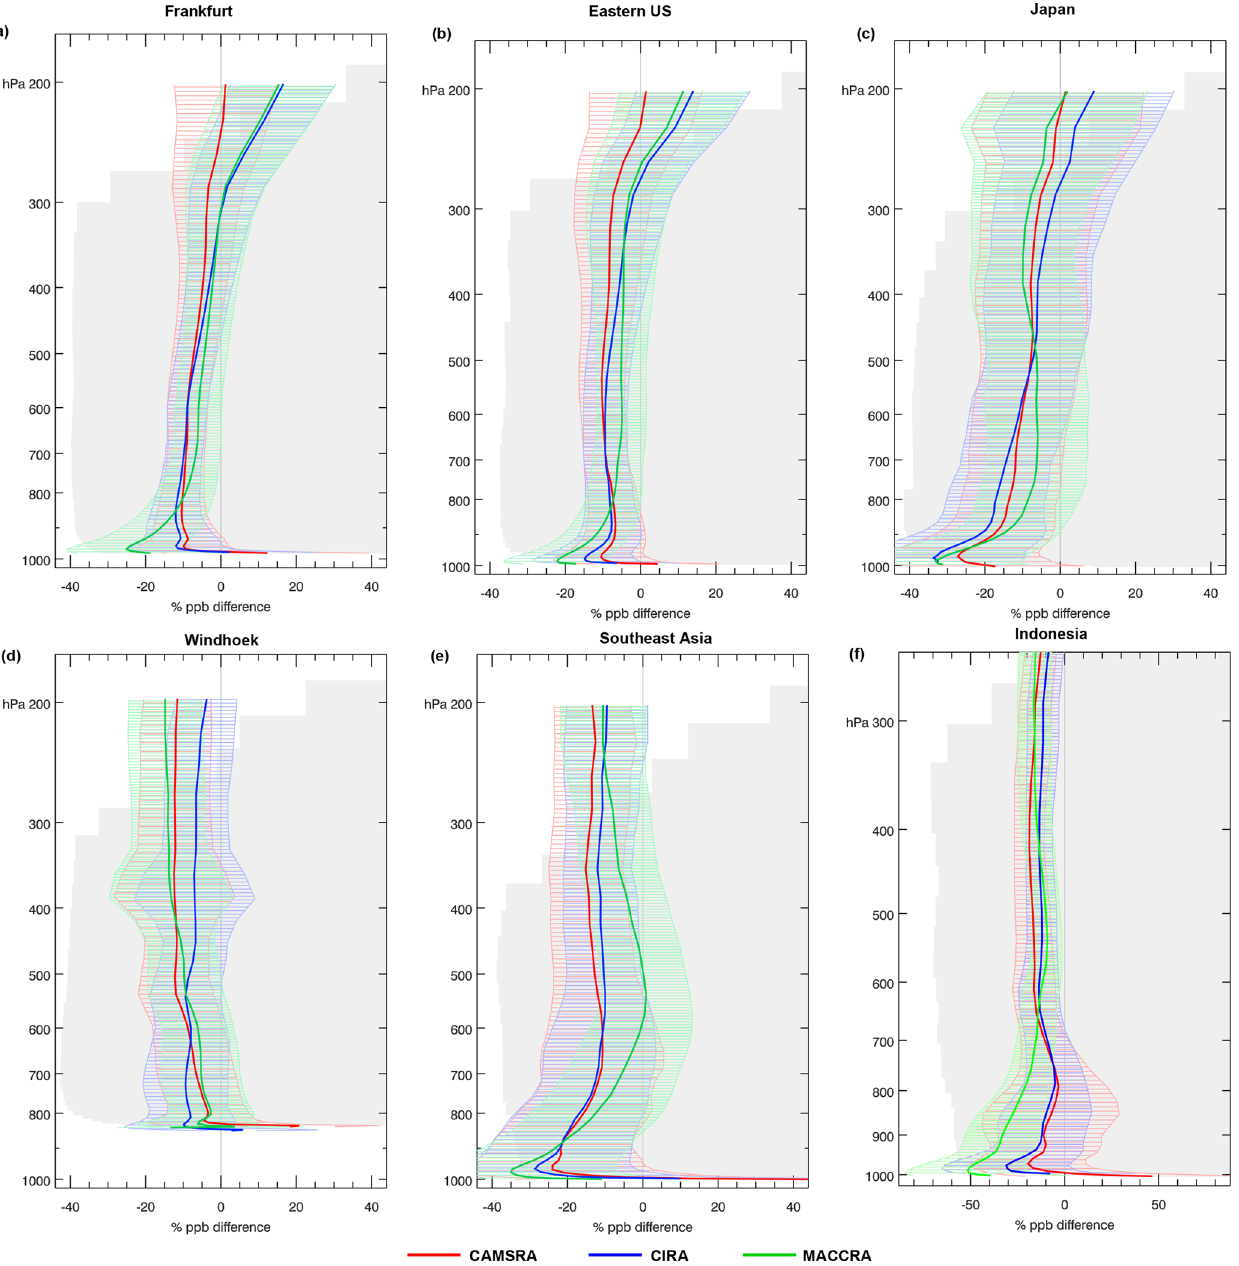
Figure 14. Mean relative CO bias (in %) between the reanalyses and IAGOS aircraft data for CAMSRA (red), CIRA (blue) and MACCRA (green) at (a) Frankfurt, (b) eastern US airports, (c) Japanese airports, (d) Windhoek, (e) Southeast Asian airports and (f) Indonesian airports (note the different scale of the axis for f ). The shaded areas show plus or minus 1 standard deviation. For CAMSRA and CIRA the average is calculated over the period 2003–2016, and for MACCRA the average is calculated only for